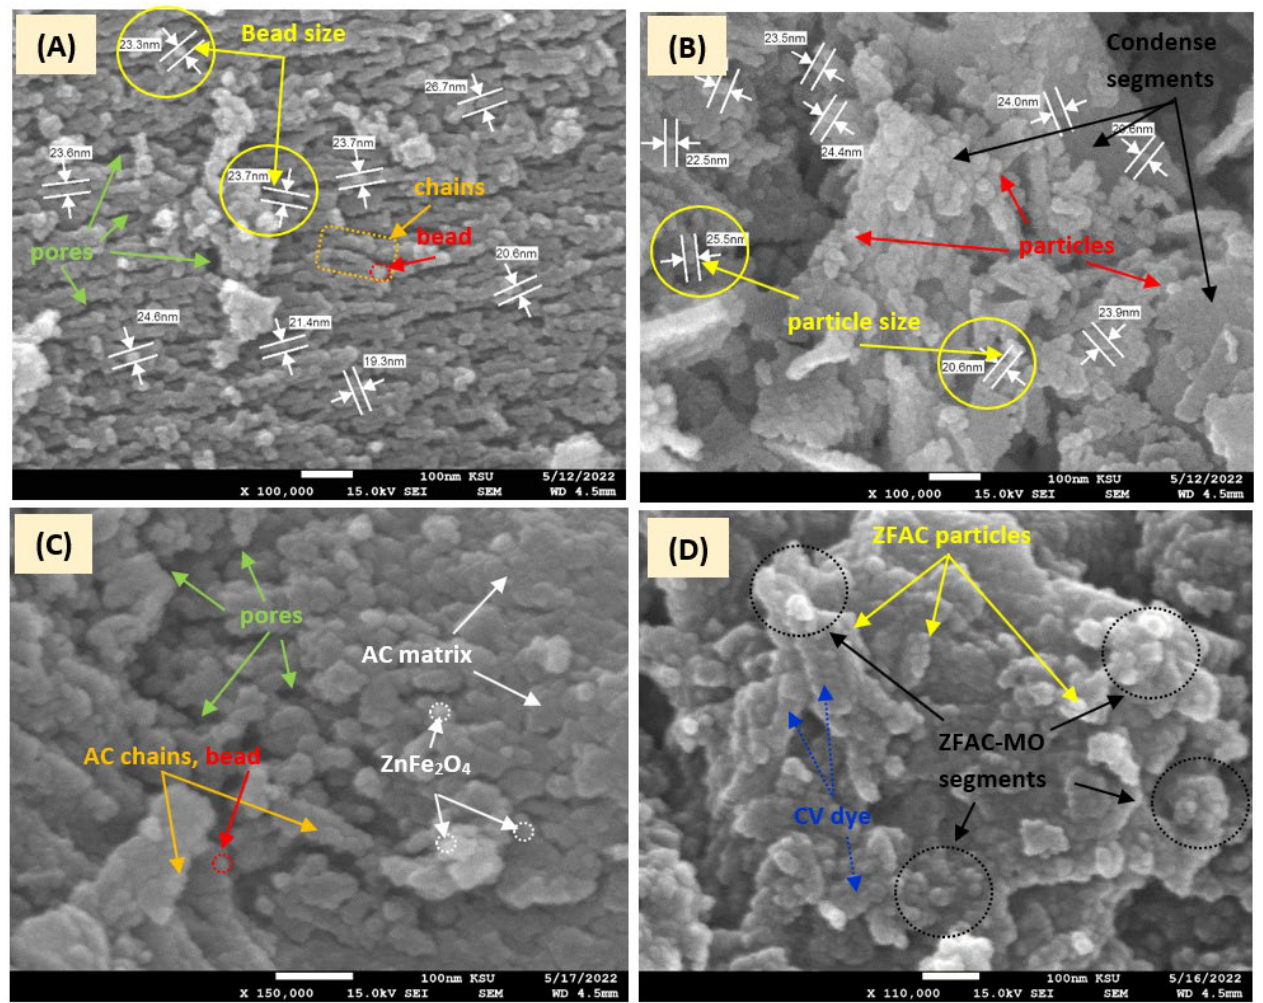
Figure 5. Scanning electron micrographs (SEM) of ( A ) activated carbon (AC); ( B ) ZnFe 2 O 4 ; ( C ) ZFAC, free adsorbent; ( D ) ZFAC-CV, dye-loaded adsorbent. Scale bar 100 nm; magnification 100,000–150,000×; acceleration 15.0 kV.